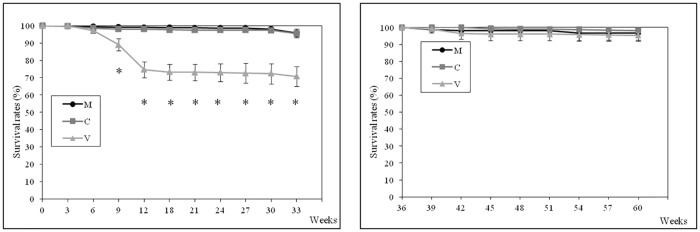
Survival during the first (on the left) and the second period (on the right) of the feeding trial.Data are expressed as mean ± standard deviation. Fish survival is expressed as % of survivors in relation to the initial number of fish in each tank, at each experimental period. *, statistically significant differences between V- vs C- and M-fed fish (one-way ANOVA, p<0.05).